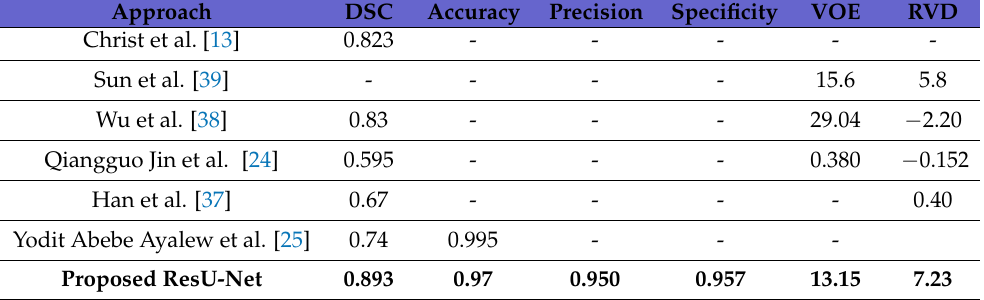
Table 5. Result comparison of ResU-Net based liver tumor segmentation with state-of-art techniques.